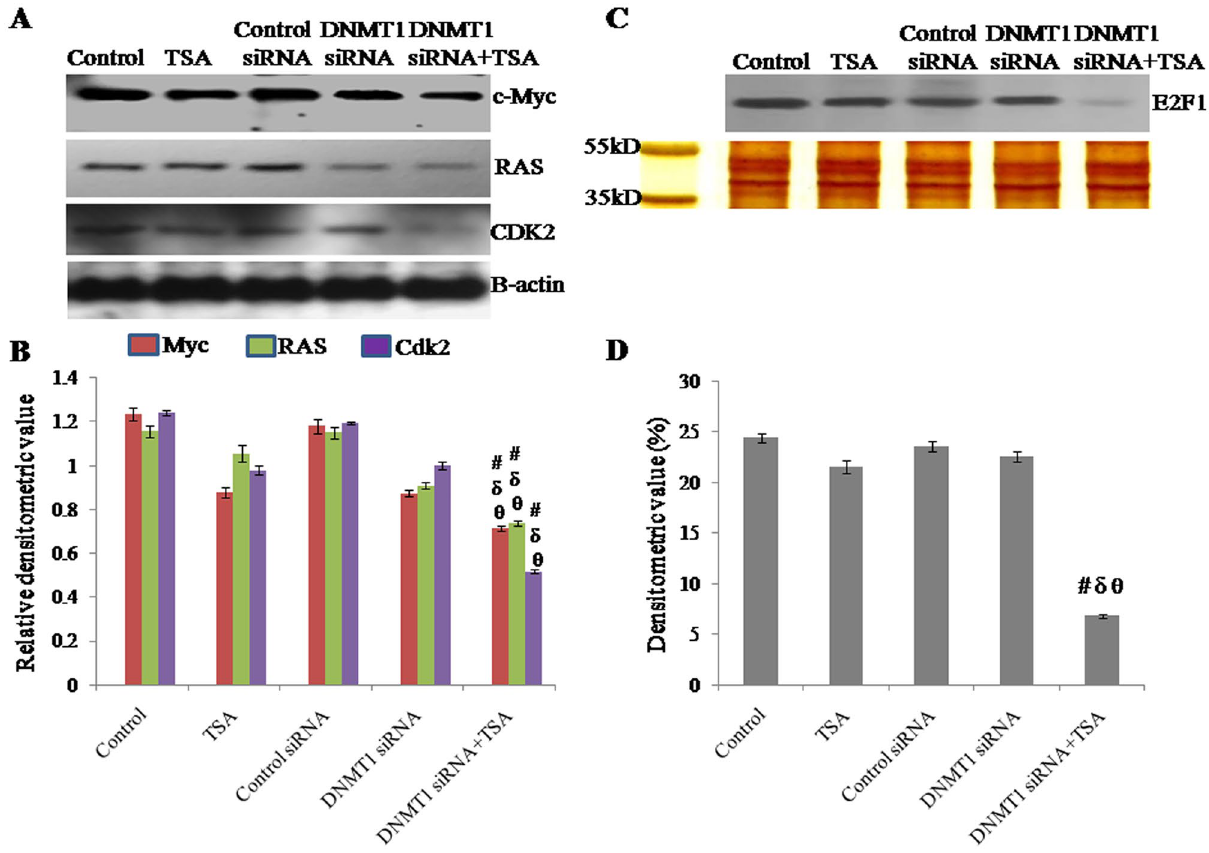
Figure 10. Protein level (expression) of ( A ) c-Myc, RAS and CDK2 analyzed by Western analysis using β-actin as loading control, ( B ) relative densitometric value obtained from densitometric scanning after normalization with β-actin. The representative blots of replicates were presented here. The full-length original images (cropped) of representative blots were presented in the supplementary Fig. S9 of Supplementary information file. Activation and nuclear translocation of ( C ) E2F1 analyzed by Western analysis of nuclear protein, and SDS- PAGE and silver staining of whole nuclear extract (protein) showing protein integrity and equal loading, ( D ) Densitometric value obtained from densitometric scanning. The representative blot of replicates was presented here. The full-length original images (cropped) of representative blot and silver stained gel were presented in the supplementary Fig. S10. Data was represented as mean ± SEM., n = 3, p < 0.05. #, δ and θ represent; compared to control group, TSA treated group and DNMT1 siRNA transfected group